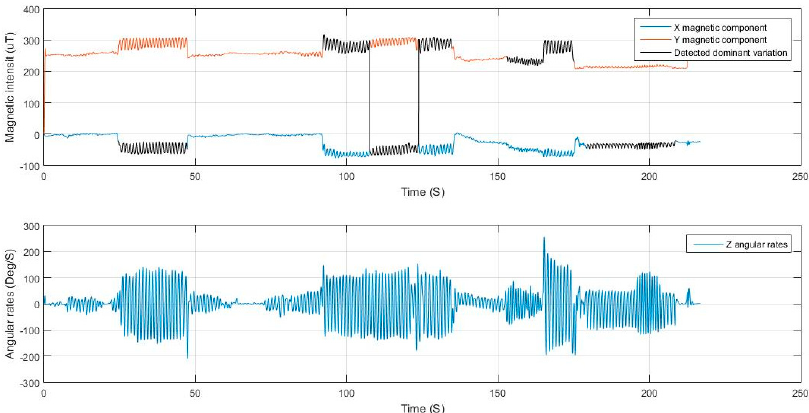
Figure 18. Magnetometer and gyroscope dominant axis of motion detection.